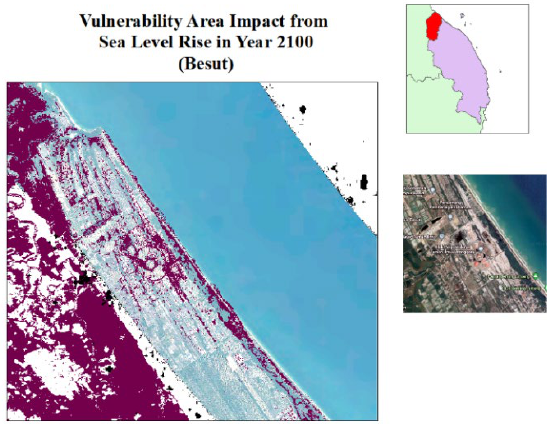
Figure 11. Simulation of inundation areas in Besut